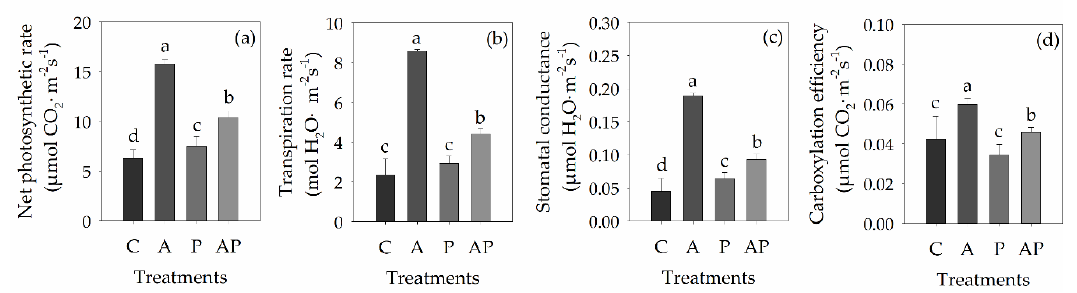
Figure 6. Effects of Glomus mosseae and Bacillus amyloliquefaciens on photosynthetic parameters of Elaeagnus angustifolia L. seedlings in saline soils. Values are the means ± standard deviation of five replicates. Value sharing the different letters indicate significant differences between treatments at the 5% level (Tukey’s t -test). C: Control, A: AMF ( Glomus mosseae ) treatment, P: PGPR ( Bacillus amyloliquefaciens ) treatment, AP: AMF + PGPR treatment. ( a ) net photosynthetic rate, ( b ) transpiration rate, ( c ) stomatal conductance, ( d ) carboxylation efficiency.